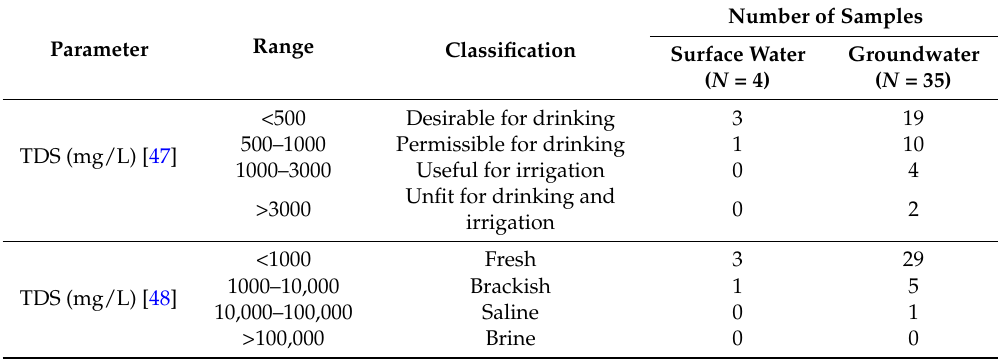
Table 1. Water type classification based on total dissolved solids (TDS).